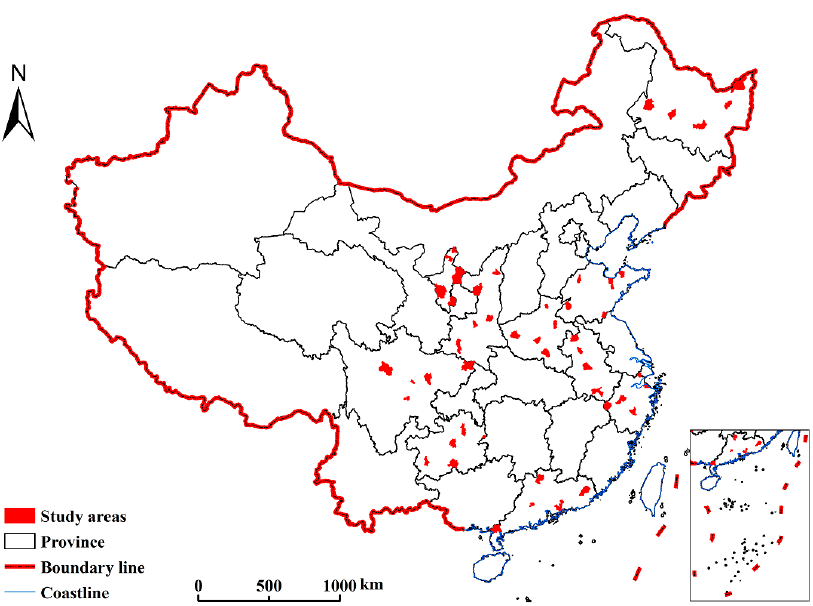
Figure 1. Distribution of household survey sites.